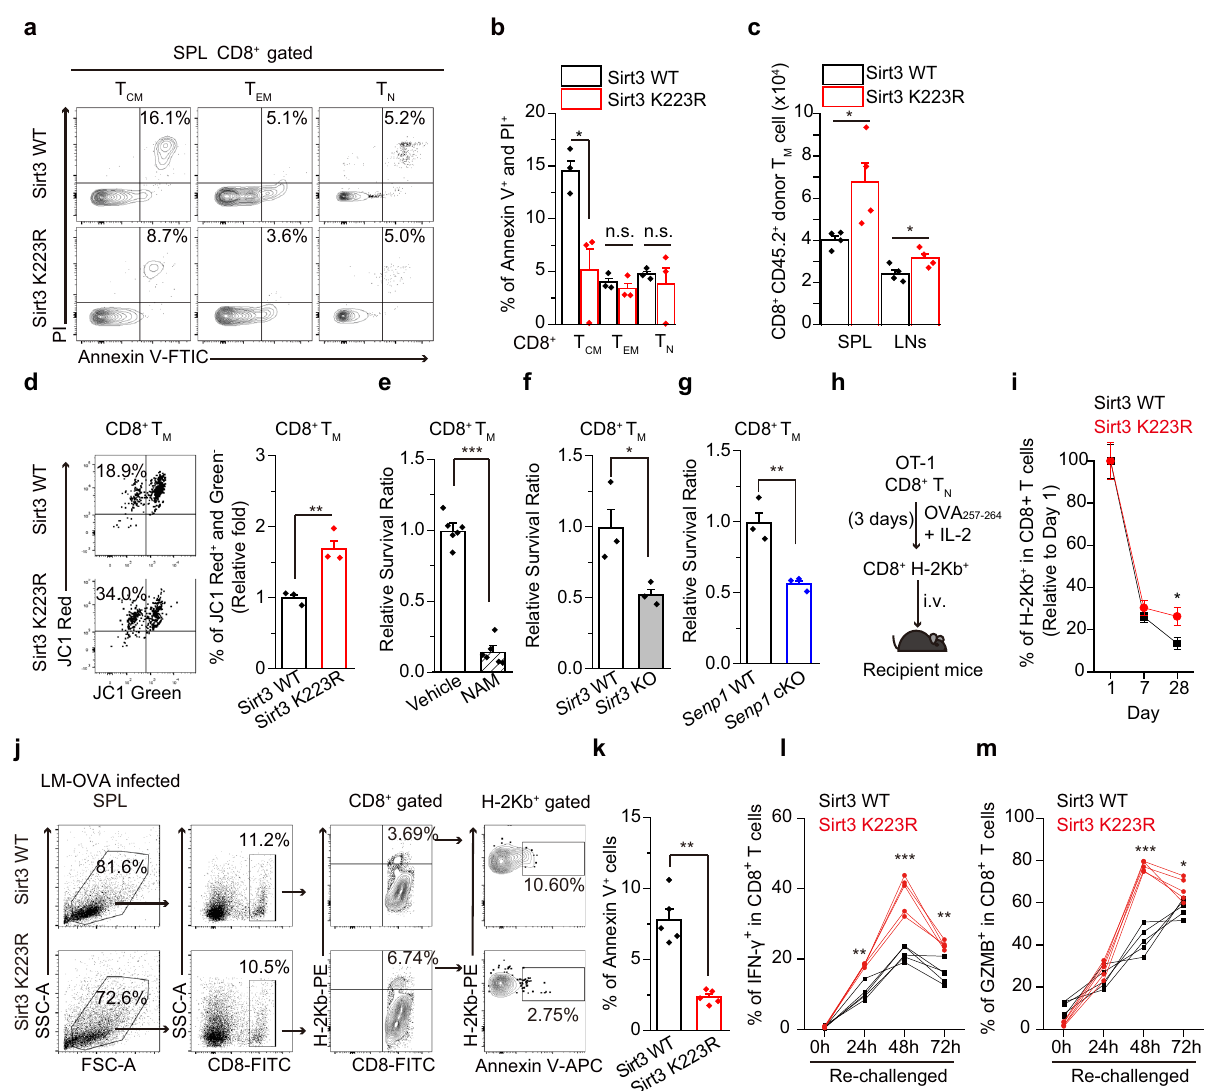
Fig. 3 SENP1-Sirt3 axis enhances the survival of T M cells. a , b The apoptotic ratios of CD8 + T CM , T EM and T N cells from Sirt3 WT or K223R mouse splenocytes were measured ( n = 3 mice, * P = 0.028). c T M cells (1.5×10 6 , CD45.2) generated from Sirt3 WT or K223R mice were injected into congenic recipient mice (CD45.1). The donor T M cell numbers in the recipient spleen (SPL) or lymph nodes (LNs) were analysed on day 2 ( n = 4 mice, * P = 0.042 in SPL and * P = 0.046 in LN). d T M cells generated from Sirt3 WT or K223R mice were analysed by JC-1 staining. ( n = 3 biologically independent samples, ** P = 0.0083). e The survival ratio of T M cells treated with NAM (5 mM) on day 3 was analysed ( n = 6 biologically independent samples, *** P < 0.0001). f The survival ratio of T M cells from Sirt3 WT or Sirt3 -KO mice was detected ( n = 3 biologically independent samples, * P = 0.047). g The survival ratio of T M cells from Senp1 WT or cKO mice was analysed ( n = 3 biologically independent samples, ** P = 0.0089). h , i The activated OT1 T cells (H-2Kb + ) were transplanted into congenic recipient mice (1.0 × 10 7 /mouse) ( h ). The H-2Kb + populations in the recipient blood were analyzed ( n = 7 mice, * P = 0.024) ( i ). j , k The apoptotic ratio of spleen CD8 + H-2Kb + cells from recipients was quanti fi ed after 21 days LM-OVA infection in vivo ( n = 5 mice, ** P = 0.0016).). l , m The populations of IFN- γ ( l ) - or Granzyme B (GZMB) ( m )-positive T cells in T M cells were analysed after re-challenge ( n = 5 mice, ** P